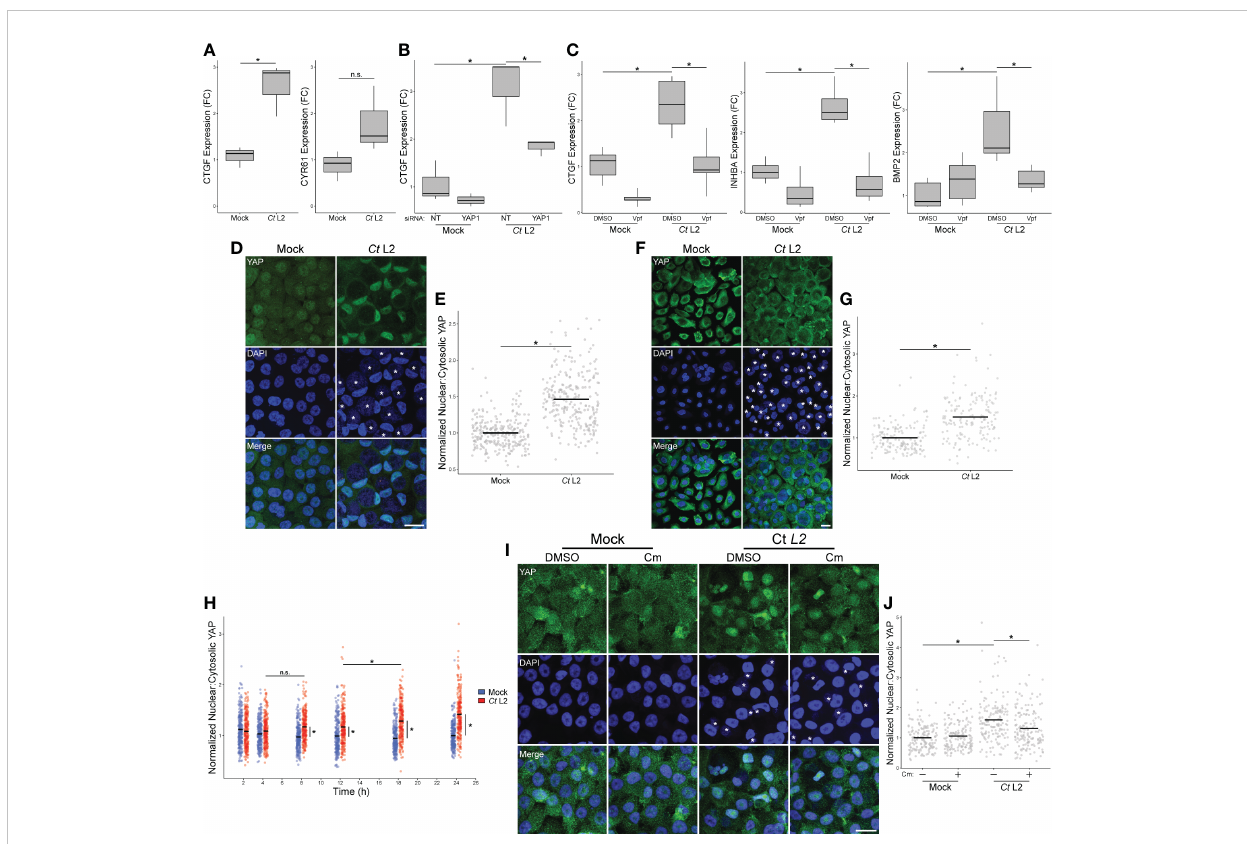
FIGURE 2 Chlamydia infection promotes YAP nuclear translocation. (A) Expression of CTGF and CYR61 at 24 hpi in mock- and Ct L2-infected End1 cells, as measured by RT-qPCR. n = 3 biological replicates; fold changes are relative to mean expression of the mock-infected and untreated control. Whiskers: minimum to maximum; n.s.: not signi fi cant (p-values > 0.05), asterisks: p-values ≤ 0.05, using pairwise Student ’ s t-tests and Bonferroni ’ s correction for multiple comparisons. (B) Expression of CTGF at 24 hpi in mock- and Ct L2-infected End1 cells transfected with non-targeting (NT) or YAP1-targeting siRNA (10 nM for 24 h prior to infection), as measured by RT-qPCR. n = 3 biological replicates; fold changes are relative to mean expression of the mock-infected and untreated control. Whiskers: minimum to maximum; asterisks: p-values ≤ 0.05, using pairwise Student ’ s t-tests and Bonferroni ’ s correction for multiple comparisons. (C) Expression of CTGF, INHBA, and BMP2 at 24 hpi in mock- and Ct L2-infected End1 cells treated with the YAP-TEAD inhibitor vertepor fi n (Vpf, 5 m M for 16 h starting at 8 hpi), as measured by RT-qPCR. n = 5 biological replicates; fold changes are relative to mean expression of the mock-infected and untreated control. Whiskers: minimum to maximum; asterisks: p-values ≤ 0.05, using pairwise Student ’ s t-tests and Bonferroni ’ s correction for multiple comparisons. (D) Representative micrographs of YAP (green)